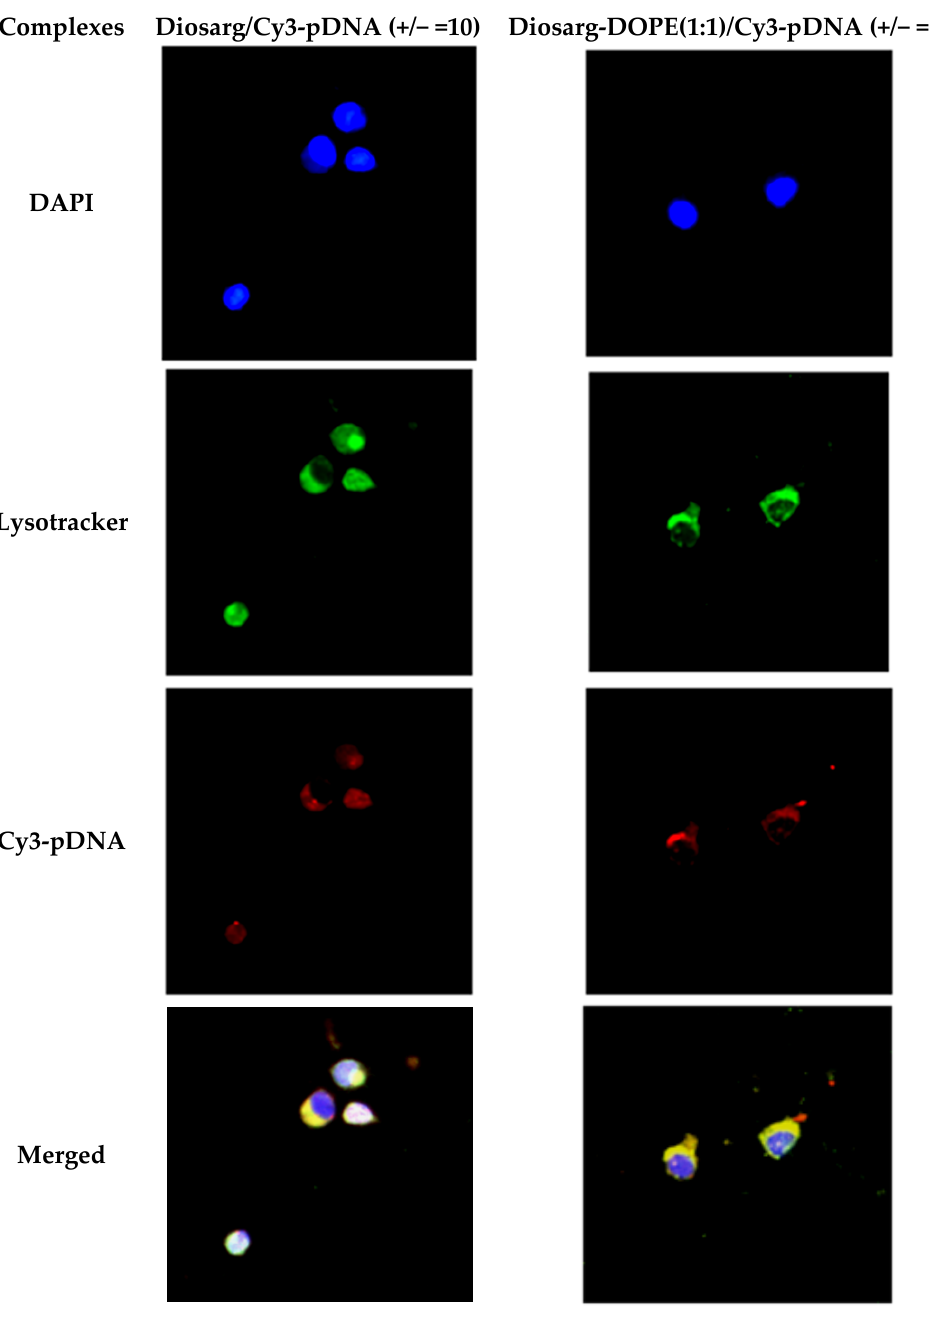
Figure 8. Intracellular localization of the Diosarg lipid and Diosarg-DOPE (1:1)/pDNA complexes (+/− = 10) in H1299 cells observed and recorded by fluorescence microscopy (blue: DAPI stained cell nuclei; green: Lysotracker-stained lysosome; red: Cy3-labeled pDNA).